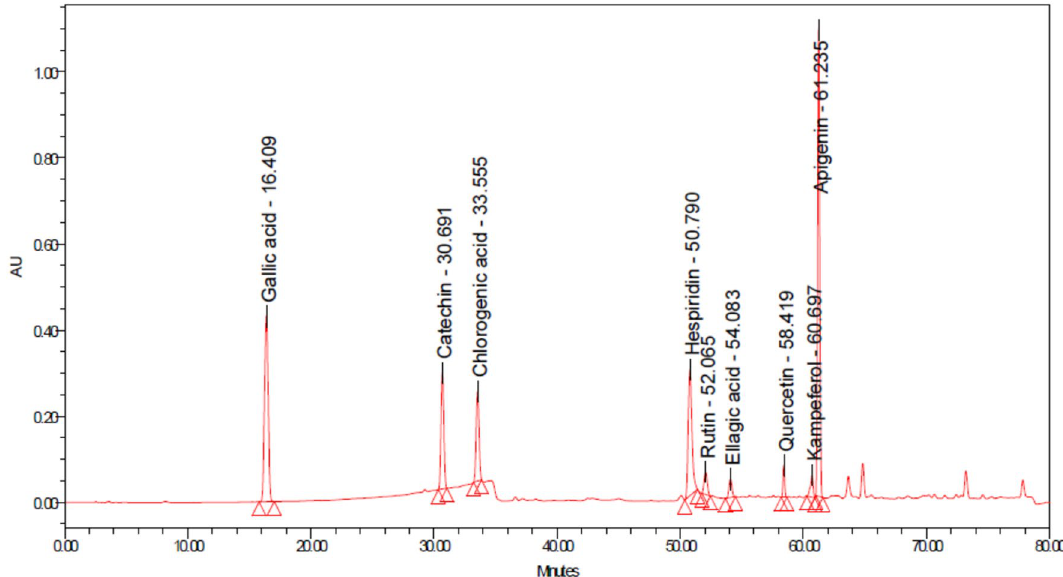
Figure 2. HPLC chromatogram detected of some phenolic and flavonoid contents of D. caffra fruit